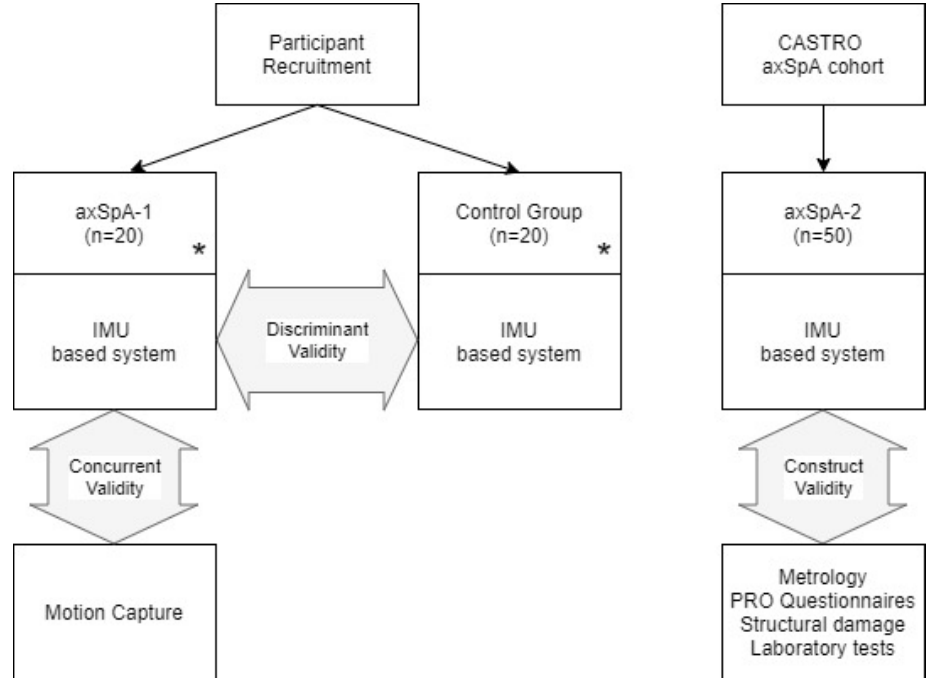
Figure 1. Study flow chart: Participants and measures for each validation. * age- and sex-matched groups.